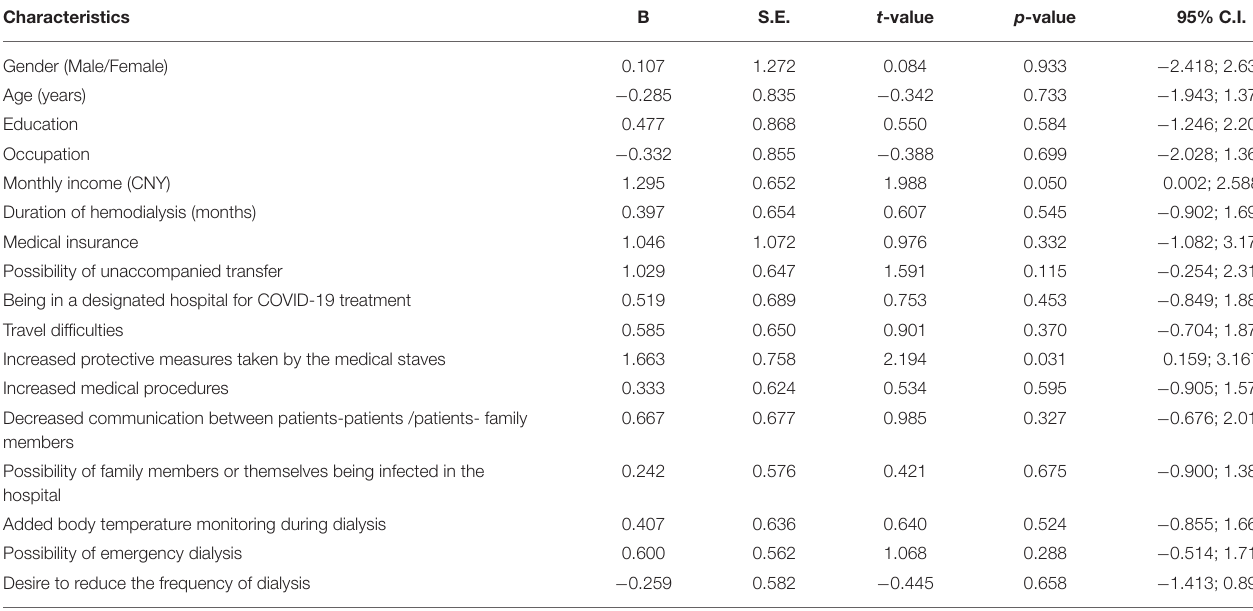
TABLE 5 | Univariate linear regression analysis of factors predictive of elevated anxiety symptoms at 1-year follow-up. Characteristics B S.E. 95%